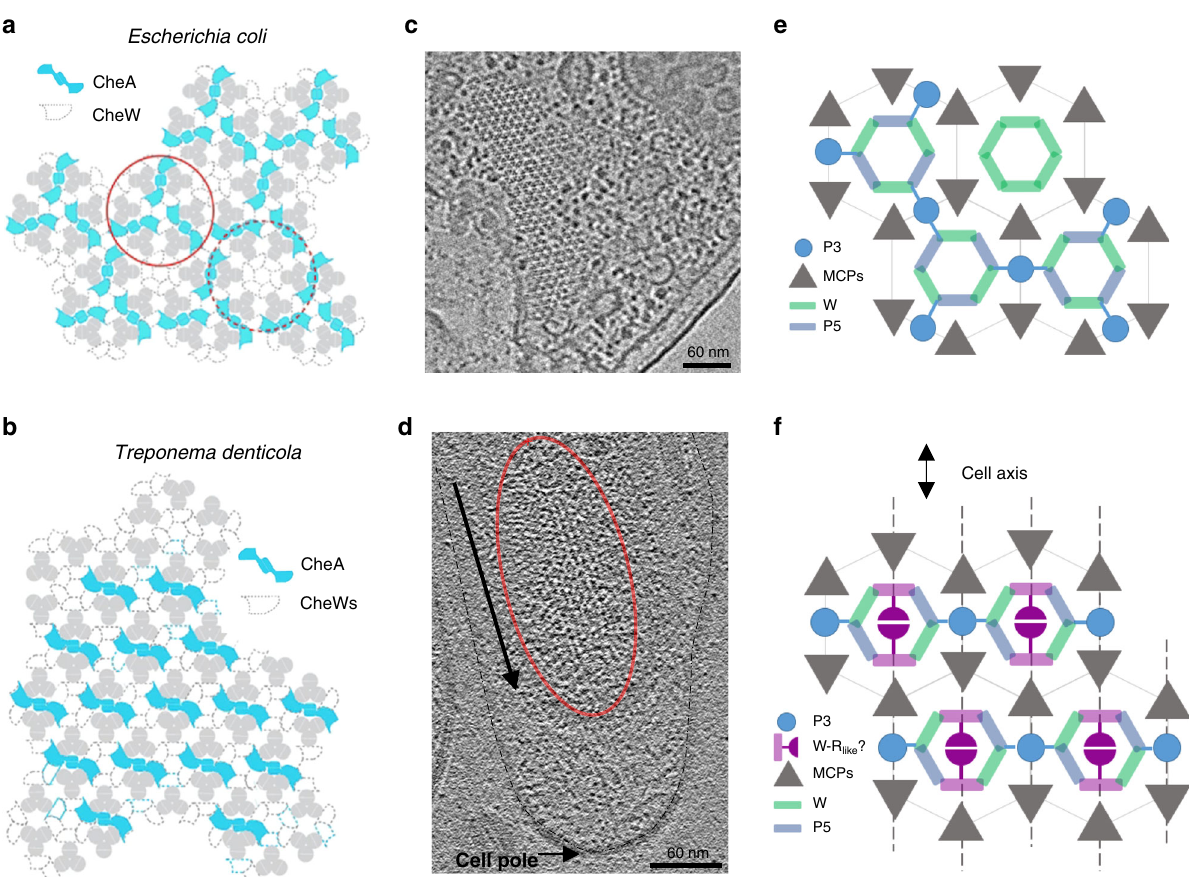
Fig. 6 The organization of CheA in Td differs from all previously reported arrangements. a The hexagonal arrangement of CheA in E. coli and other canonical chemotaxis systems. b In Td , CheA is arranged with a strict linear organization, producing “ strands ” of CheA:CheW rings linked by the CheA P3 domain. c The receptor densities in Ec (Layer 1) are apparent and hexagonal. Figure adapted from Briegel A. et al. (2013). 24 and reprinted with permission. d The densities at Layer 1 in Td (red oval) produce apparent lines of recetors, P3 and the middle density (CheR-like) that follow the axis of Td cells (black arrow). e Ec arrays possess radial P6 symmetry where all interaction interfaces are equally curved. f The Td array has a two-fold symmetry arrangement that allows receptor:CheA/W interactions that hold the CheA:CheW strands together to occur with minimal bending. Dashed lines represent the apparent lines in the tomograms. The CheR like domain may reside in the center of the CheA:CheW